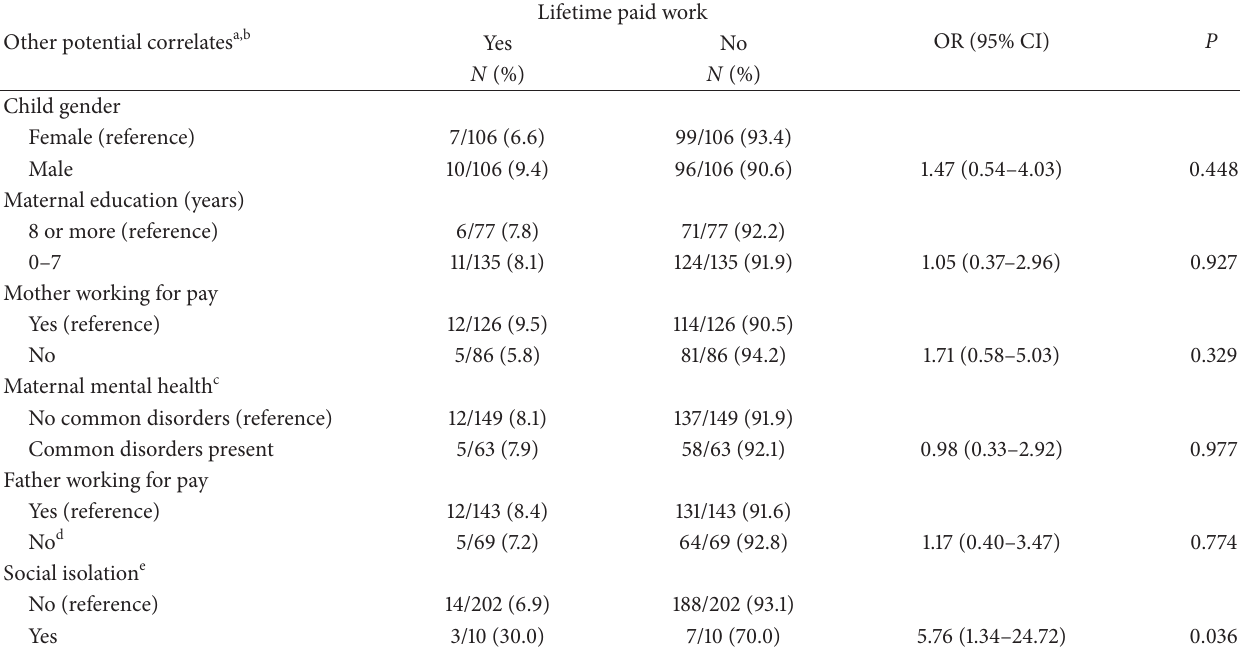
Table 3: Other potential correlates of lifetime paid work among children aged 9–13 years ( 𝑛 = 212 ) in Embu, S˜ao Paulo, Brazil.